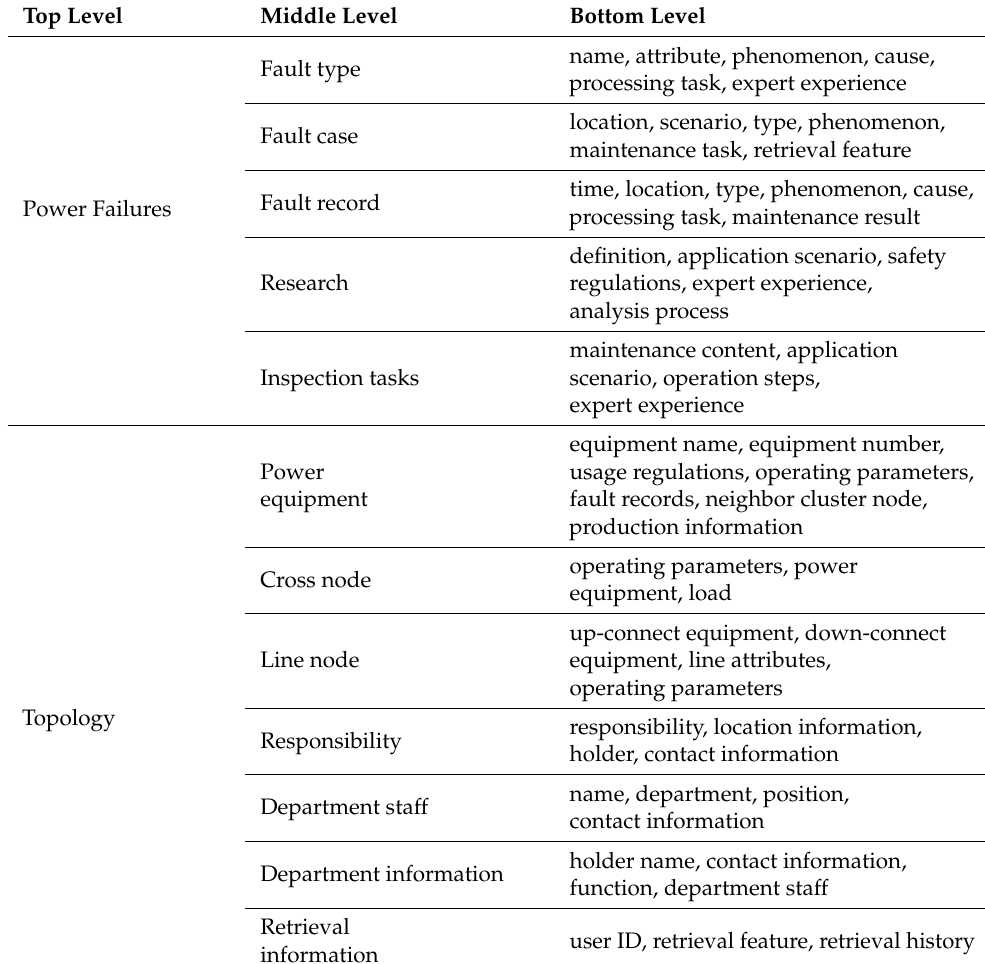
Figure 2. Intelligent fault analysis process. Table 1. Multi-business power knowledge graph ontology